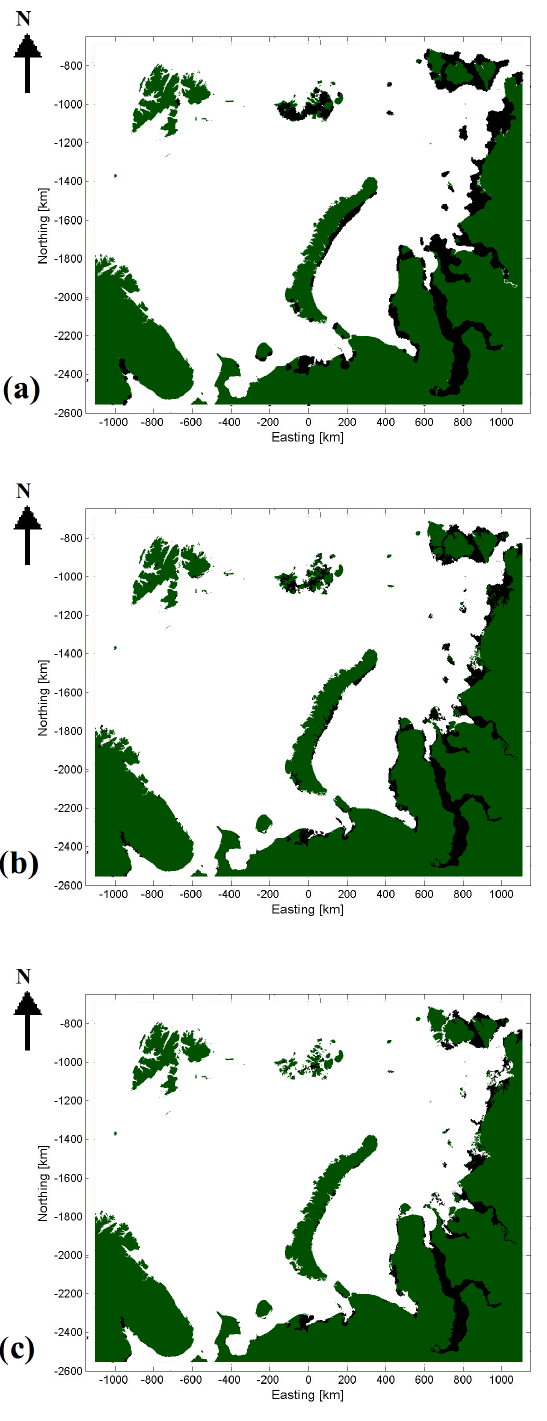
Figure 7. LFI extent based on AARI ice chart (a) , FMI-A LFI (b) and FMI-B LFI (c) of 8 March 2016. LFI areas are the black areas.